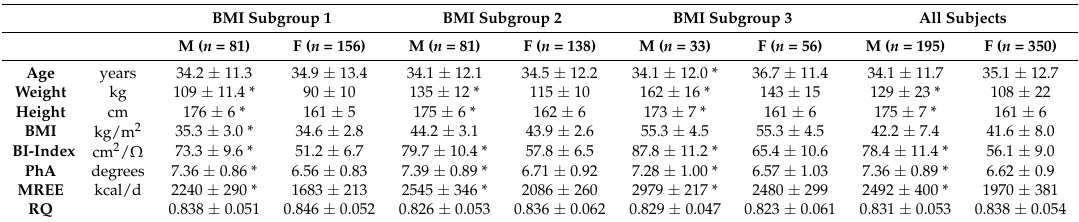
Table 2. Characteristics of BMI subgroups and the entire study sample for the validation group.